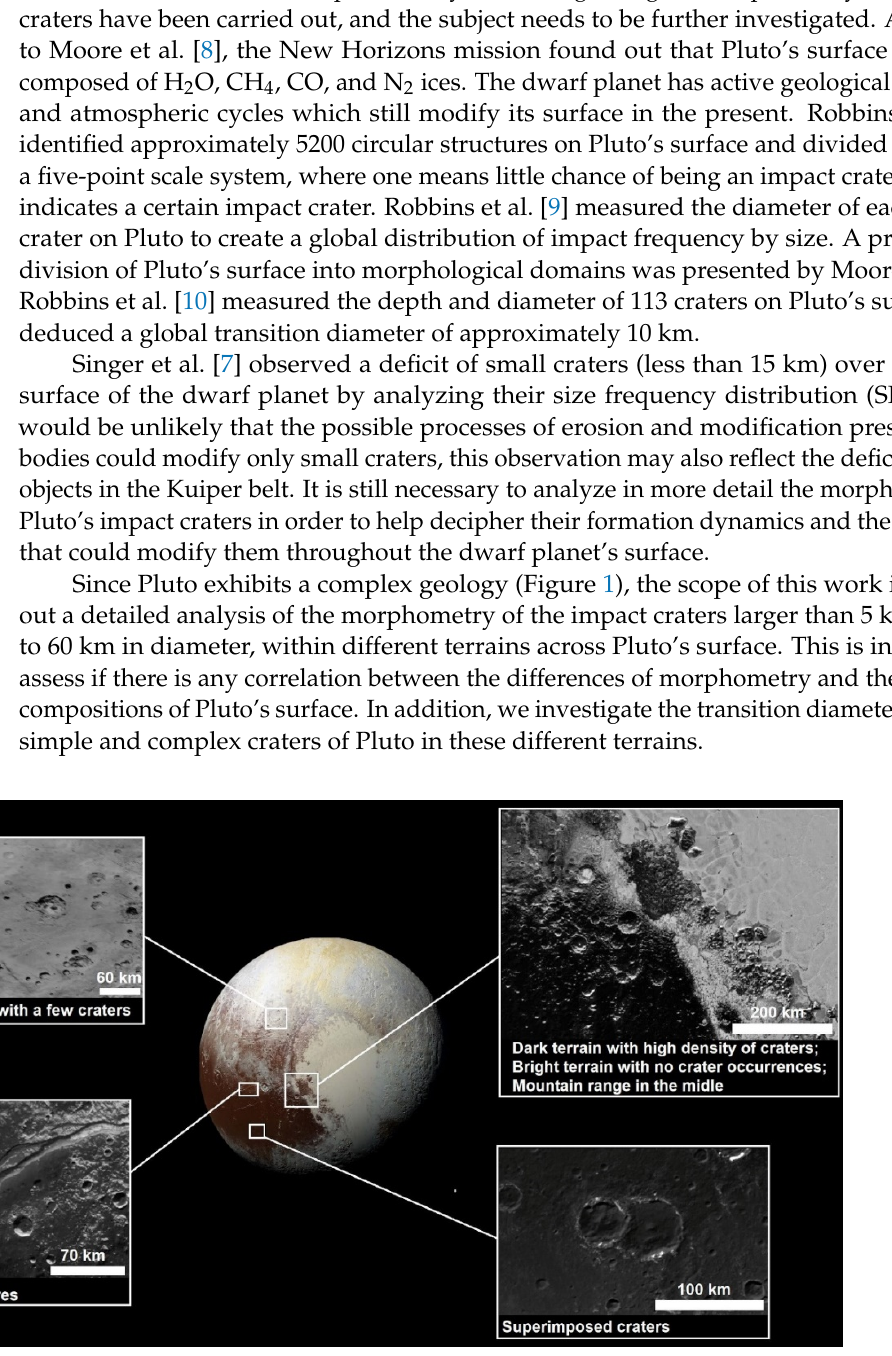
Figure 1. Global view of Pluto obtained by the combination of blue, red and infrared images taken by the Ralph/Multispectral Visual Imaging Camera (MVIC) (Image modified from Moore et al. [8] and Schenk et al. [11];